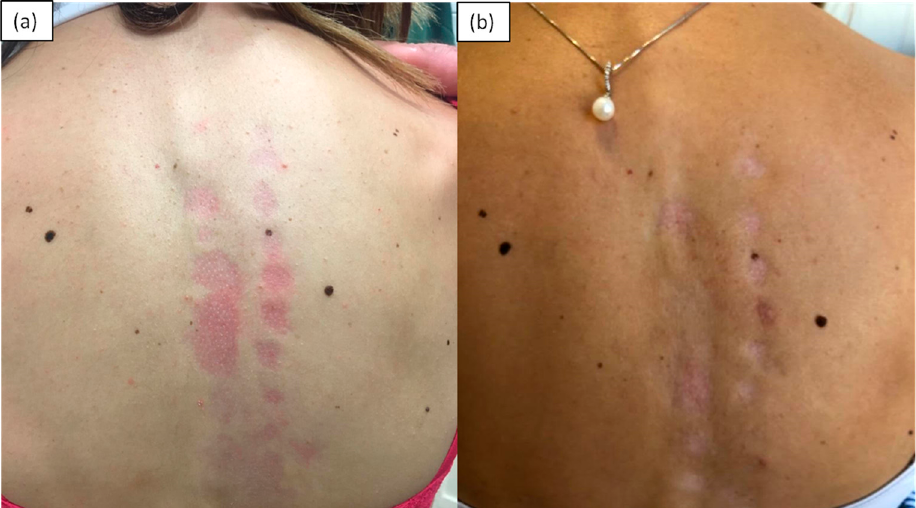
Figure 2. A 40-year-old female patient presented the rapid appearance, within 2 weeks, of roundish atrophic erythematous lesions in a linear arrangement along the spine, combined with a burning sensation ( a ). Histology showed a thin atrophic epidermis, a thickened dermis with a sclero-hyaline appearance, the absence of hair follicles and poorly represented and reduced subcutis. A diagnosis of atrophoderma of Pasini and Pierini was made. Result after 2 months of treatment with hydroxychloroquine at 200 mg/day ( b ).